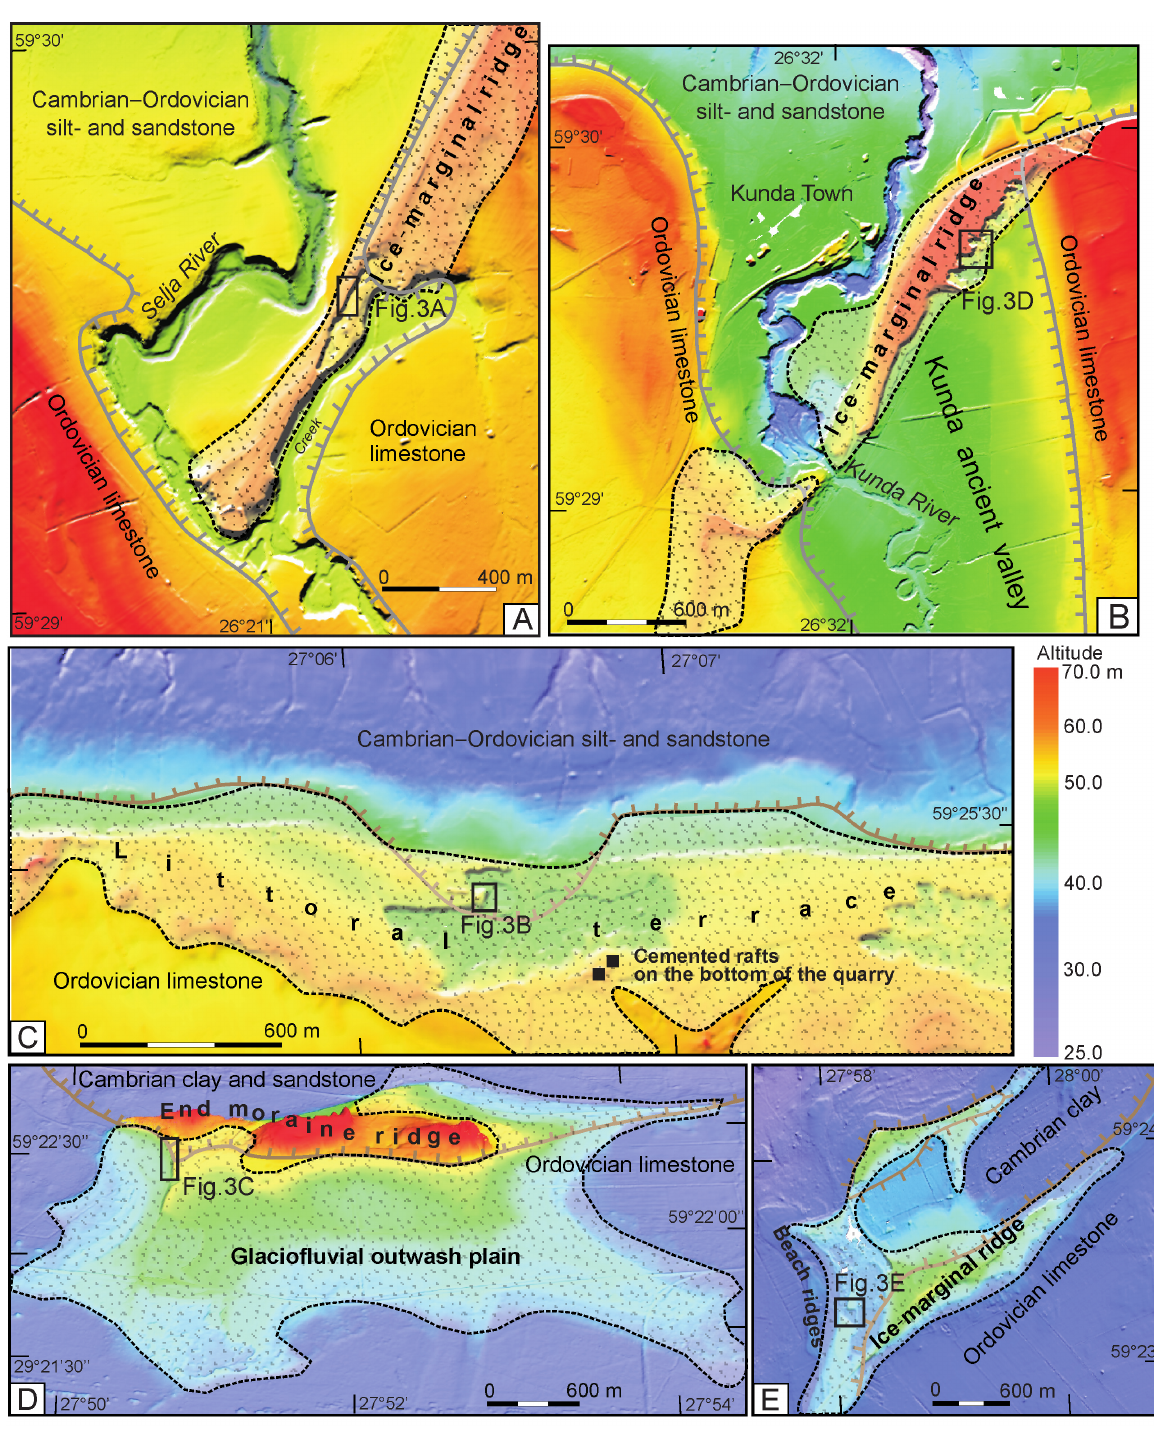
Fig. 2. Geomorphological and geological settings of the studied sites: A , Pehka; B , Kunda; C , Moldova; D , Tornimägi; E , Laagna. Colour-scaled topography is based on LIDAR measurements by the Estonian Land